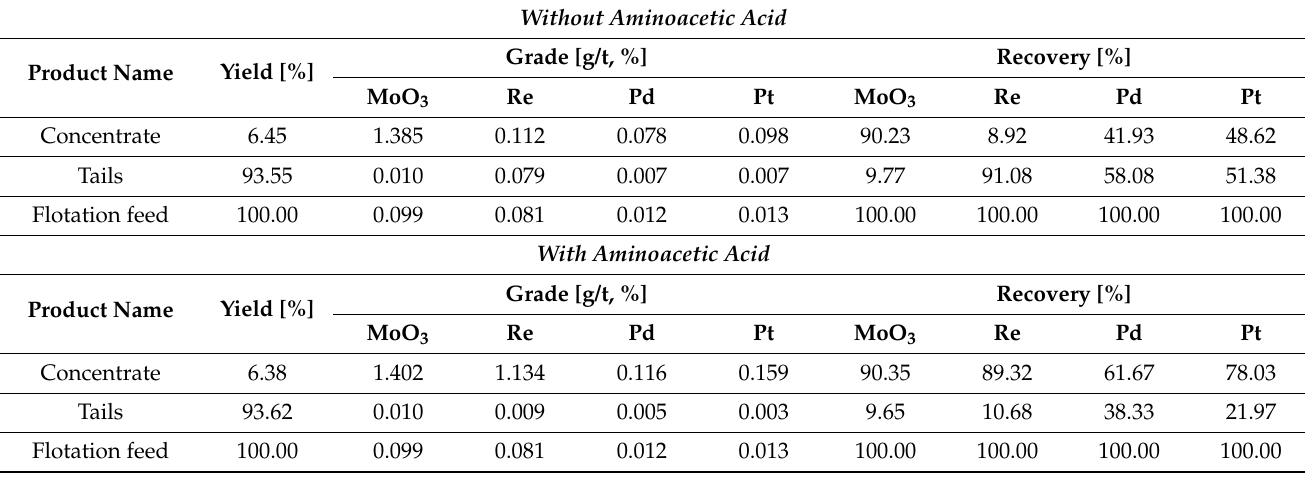
Table 11. Results of DOS flotation with and without aminoacetic